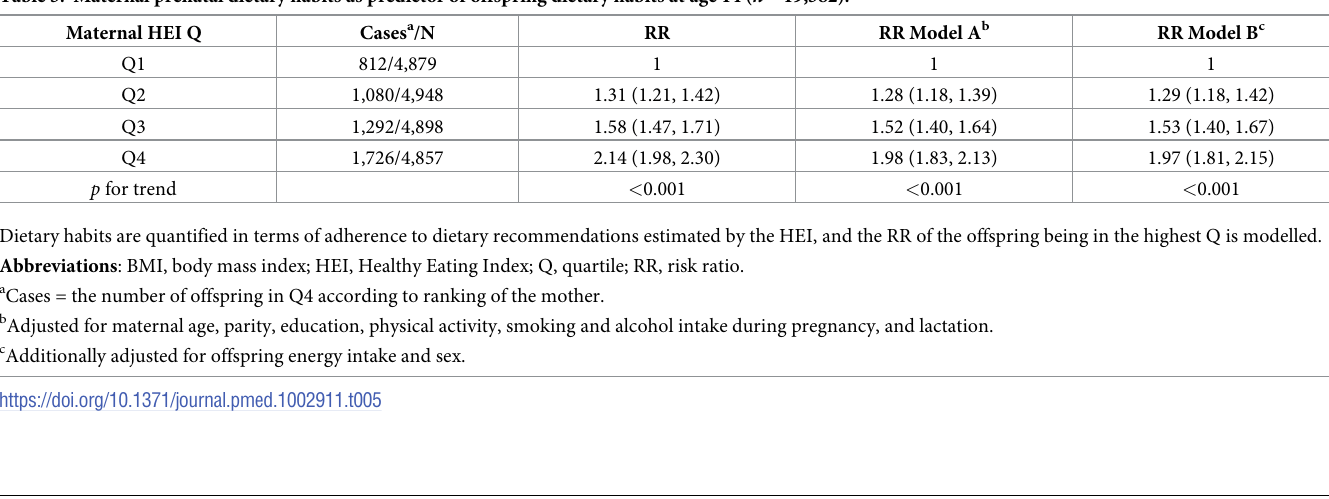
a Pearson correlations; otherwise Spearman correlations, � p < 0.001 for all correlations tested on maternal and offspring HEI as continuous score.